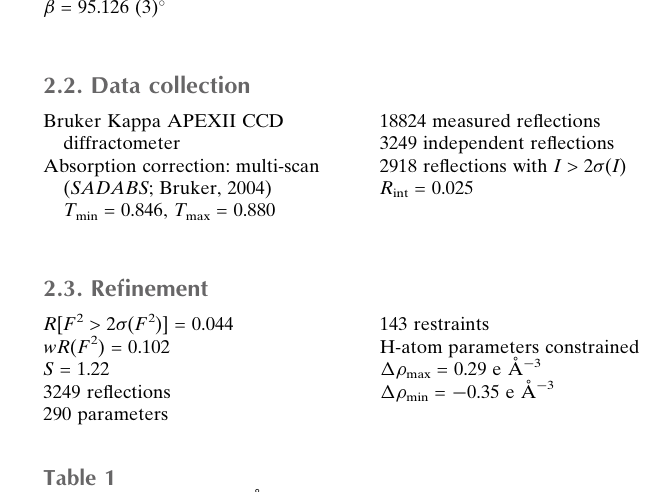
Selected bond lengths (A˚ ).